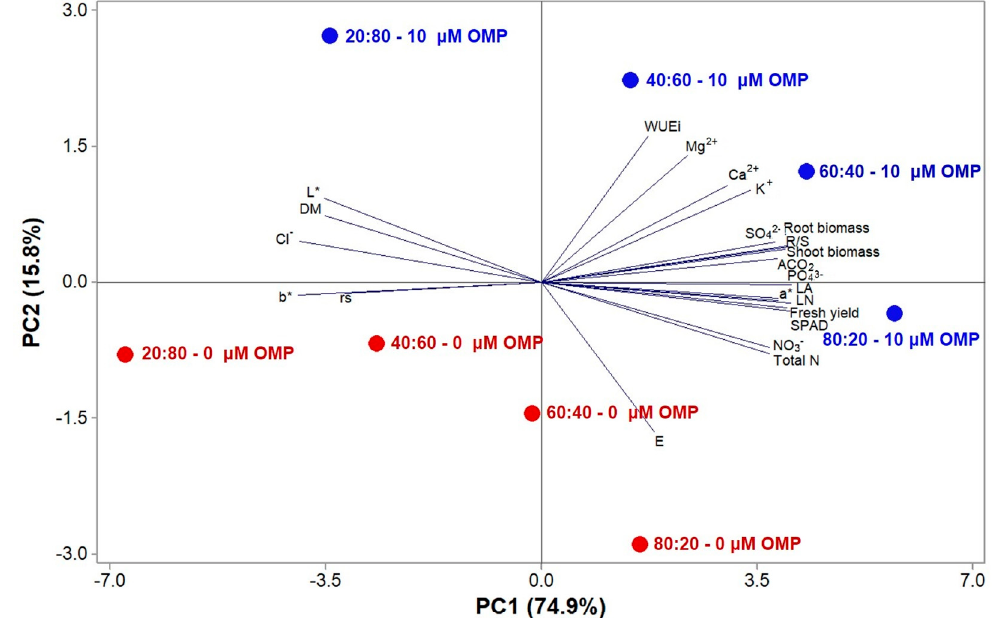
Figure 4. Principal component loading plot and scores of principal component analysis (PCA) of growth parameters, fresh yield, shoot and root dry biomass, leaf dry matter (leaf DM), leaf area (LA) and leaf number (LN), WUE i , total N, mineral concentrations, net CO 2 assimilation rate (A CO2 ), SPAD index, a*, b*, and L*, in untreated (0 µ M OMP) and treated greenhouse basil plants with 10 µ M OMP grown under different NO 3 − :Cl − ratios (80:20, 60:40, 40:60, and 20:80).